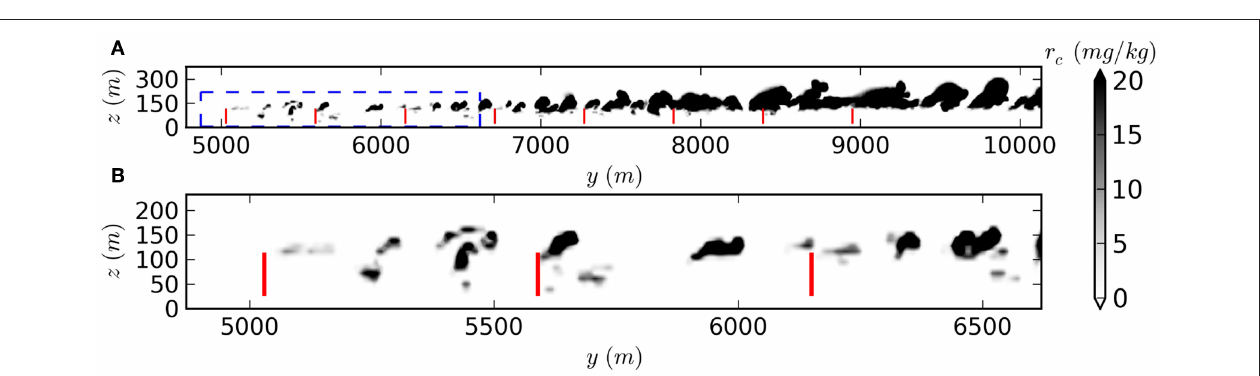
FIGURE 11 | Vertical cross-section of the cloud mixing ratio through the whole fourth row of the wind farm (A) and the firsts wind turbines (B) . The red plain lines (–) indicate the locations of wind turbines. The blue dashed line (- -) in A indicates the area of B.